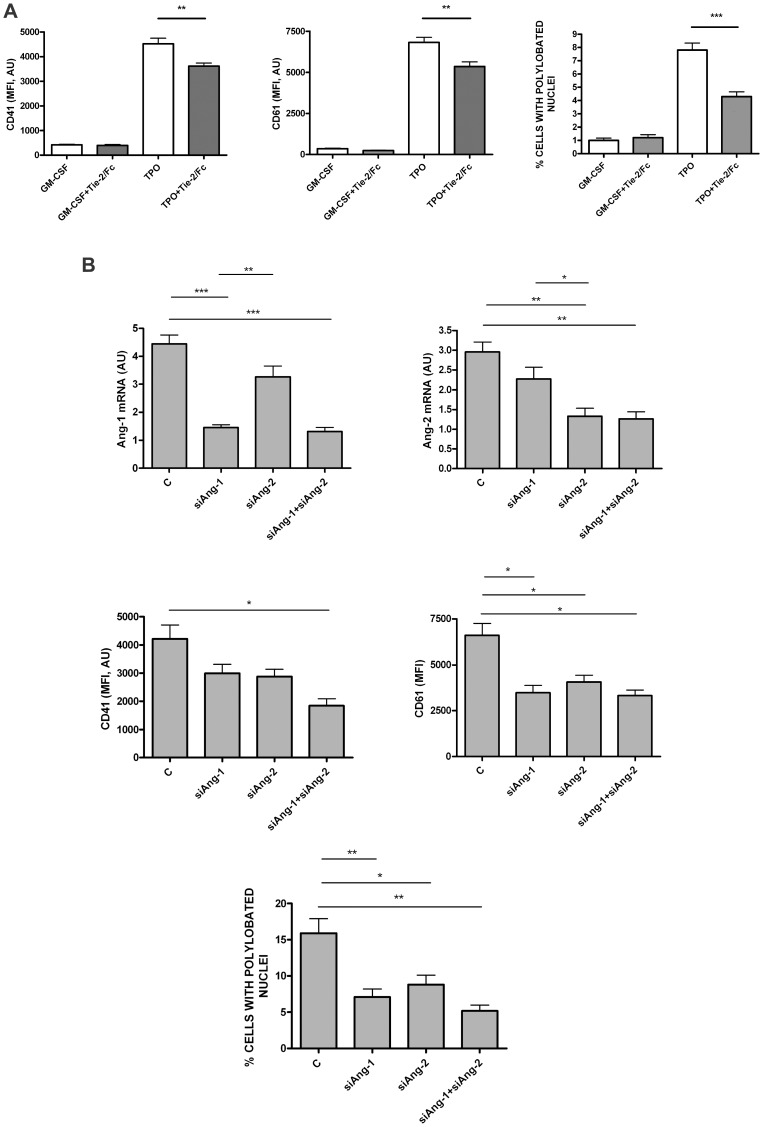
Effect of endogenous angiopoietin neutralization on Mk differentiation of UT7/mpl cells.
A- Effect of endogenous angiopoietin neutralization by Tie-2/Fc on Mk polyploidization in UT7/mpl cells. UT7/mpl cells have been grown for 7 days either in the presence of GM-CSF or TPO and either in the absence or in the presence of Tie-2/Fc; after 7 days of culture the cells have been harvested and evaluated for CD41 and CD61 expression by flow cytometry (top and middle panels) and for the proportion of cells with polylobated nuclei (bottom panel). Mean values ± SEM observed in three separate experiments. ** p<0.01; *** p<0.001. B- Effect of siAng-1 RNA or siAng-2 RNA on Mk differentiation of UT7/mpl cells. UT7/mpl cells have been transfected with either a control scramble siRNA (C ) or siAng-1 RNA or siAng-2 RNA or both siAng-1+ siAng-2 RNAs and then grown for four days in the presence of TPO and assayed for Ang-1 mRNA (left, top panel) or Ang-2 mRNA (right, top panel), for Mk membrane CD41 (left, middle panel) or CD61 (right, middle panel) antigens and for the presence of polylobated nuclei (bottom panel). Mean values ± SEM observed in three independent experiments are shown. *, **, ***: p<0.05, p<0.01, p<0.001, respectively.